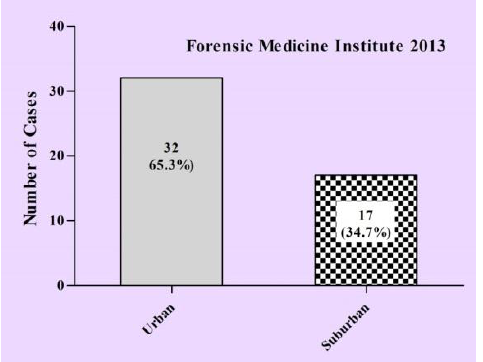
Figure (1): Geographical distribution of poisoning cases reported in Baghdad PCC during 2013. Meanwhile, the geographical distribution of poisoning cases reported in the FMI showed that cases from urban region represent 65.3% (32 cases), while those reported from suburban regions represent 34.7% (17 cases), as shown in figure 2.